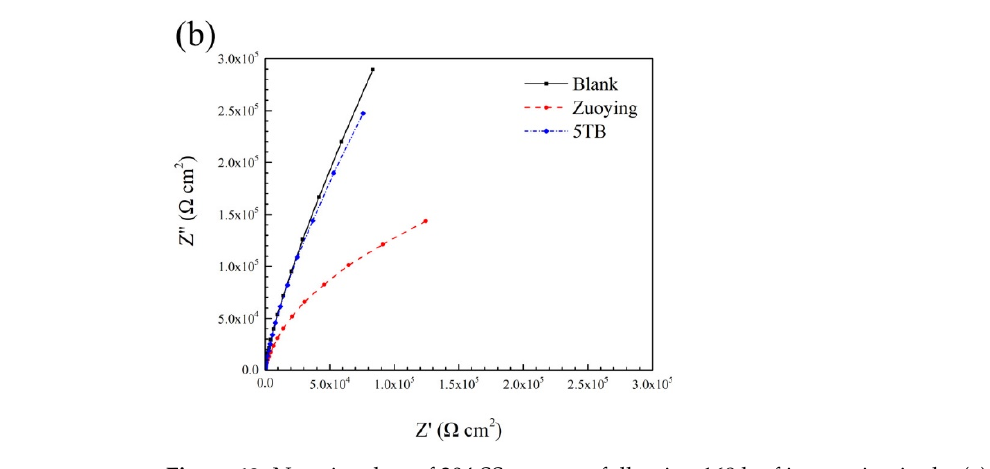
Figure 13. Nyquist plots of 304 SS coupons following 168 h of immersion in the ( a ) Tamsui inocula and ( b ) Zuoying